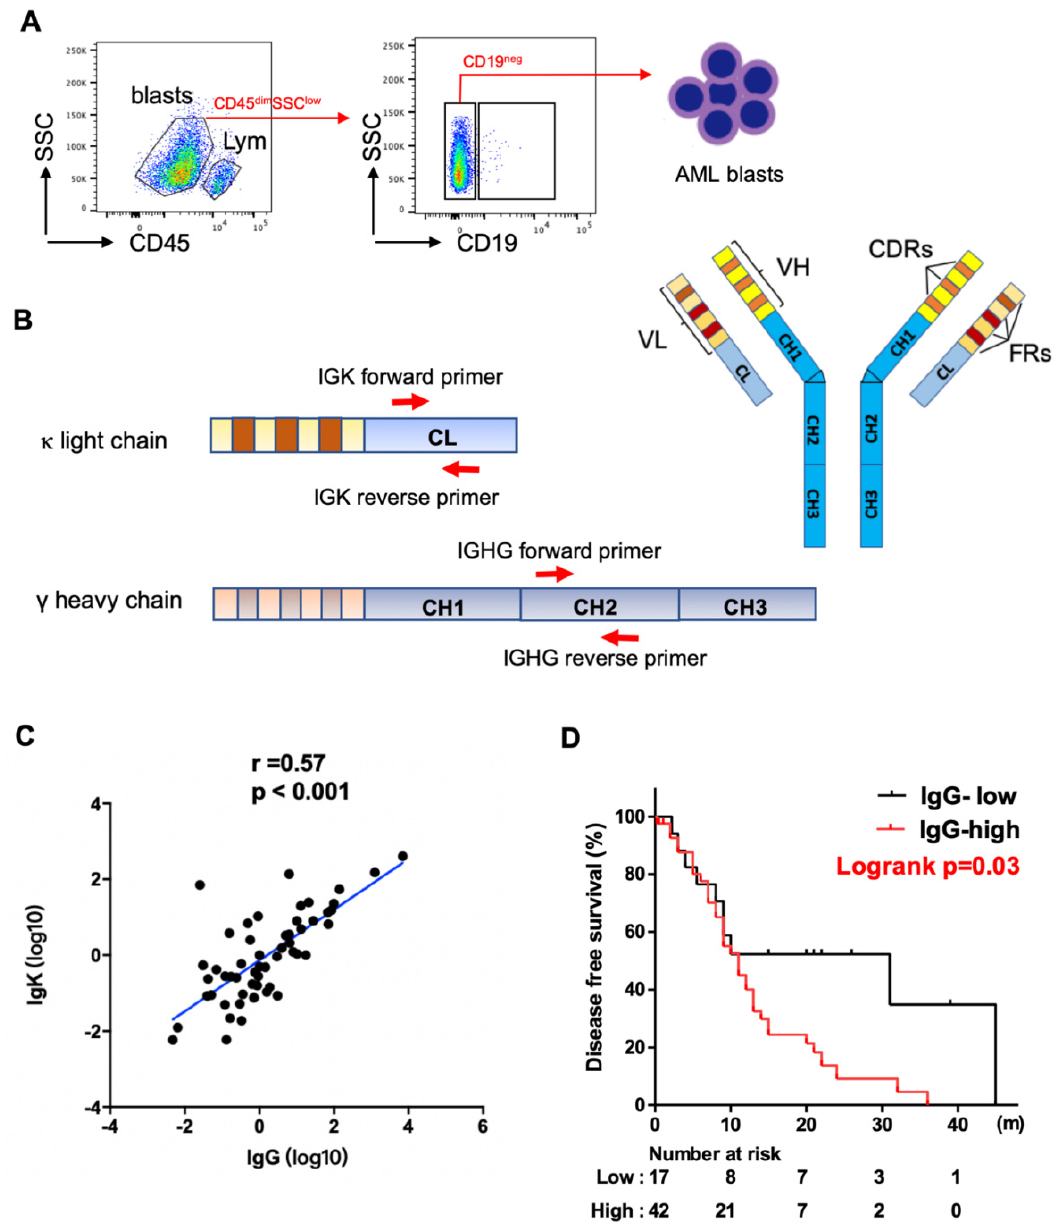
Figure 1. Expression of IGHG and IGKC in AML blasts. ( A ) Schematic map for flow cytometry sorting strategy of AML samples. Blasts: CD45 dim SSC low , lym: CD45 high SSC low lymphocytes. CD19 was further used to exclude B cell contamination from AML blasts. ( B ) Schematic map of Ig structure and primers complementary to IgG and Ig κ constant region used for qPCR analysis. IGHV: variable region of Ig heavy chain, VL: variable region of Ig light chain, CH: constant region of Ig heavy chain, CL: constant region of Ig light chain, FR: framework regions, CDR: complementary determining regions. ( C ) Spearman correlation analysis shows a strong correlation between levels of IGHG and IGKC expression. ( D ) Kaplan–Meier analysis shows higher levels of IGHG expression correlate with shorter disease-free survival in AML patients.